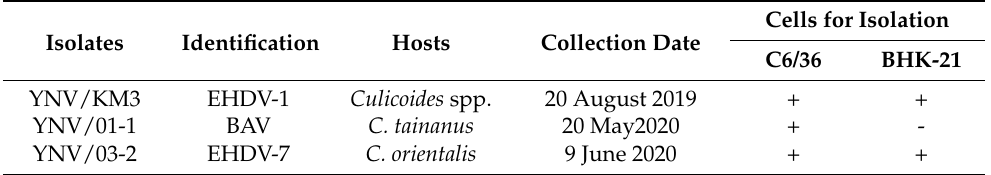
Table 3. Isolation details of three viruses isolated from Culicoides collected from Wulong village